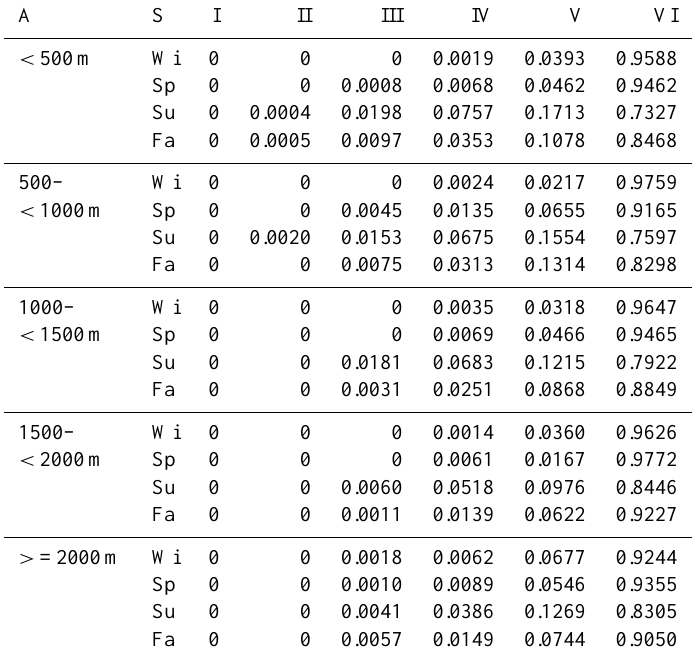
Table D6. Probabilities of cloud coverage classes for a 24h precipitation sum of > 20cm depending on explanatory variables following selected Swiss climate stations. For further description see Table D2.